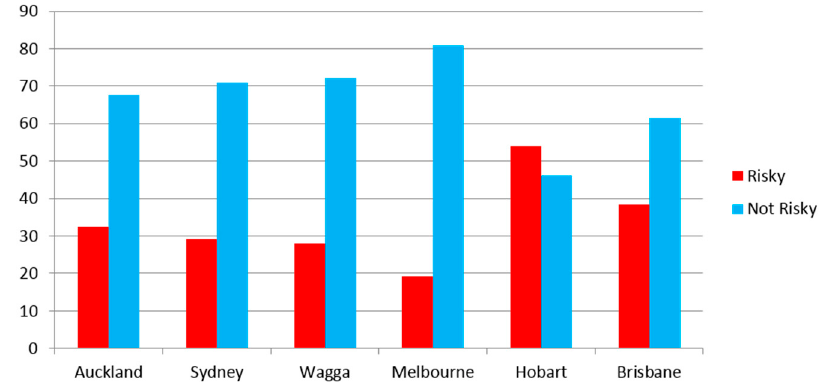
Figure 1. Percentage of participants in each location relevant to their perception of risk.